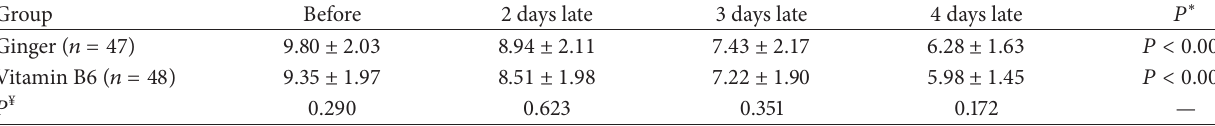
∗ Within groups. ¥ Between